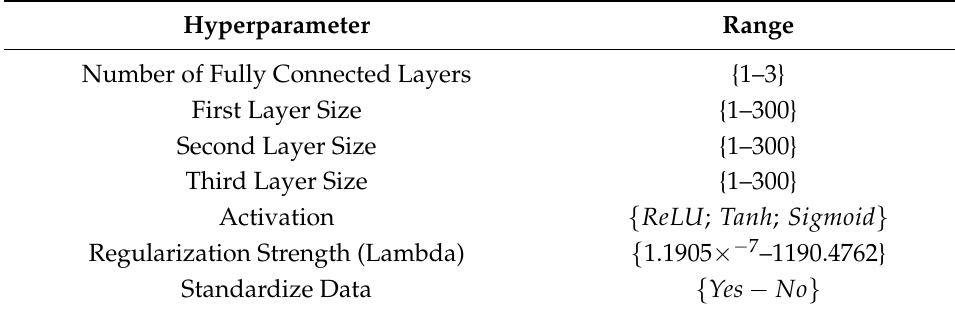
Table 4. Hyperparameter